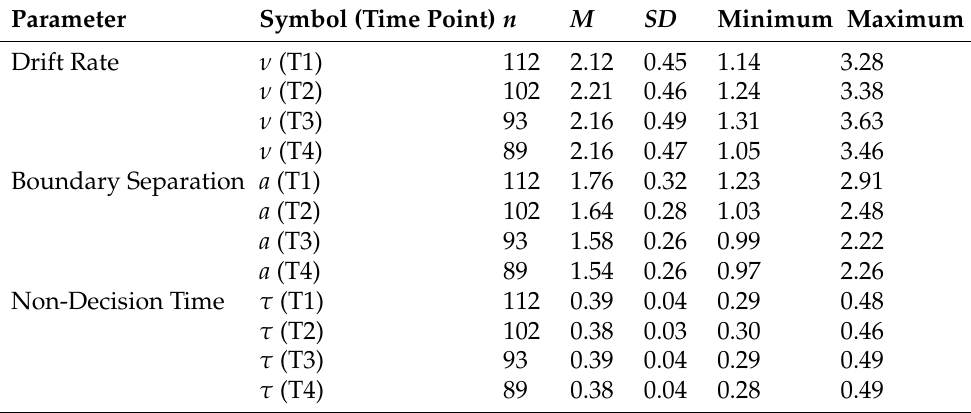
Table A2. Summary statistics of the individual diffusion model parameter estimates for each time point for Group 1.